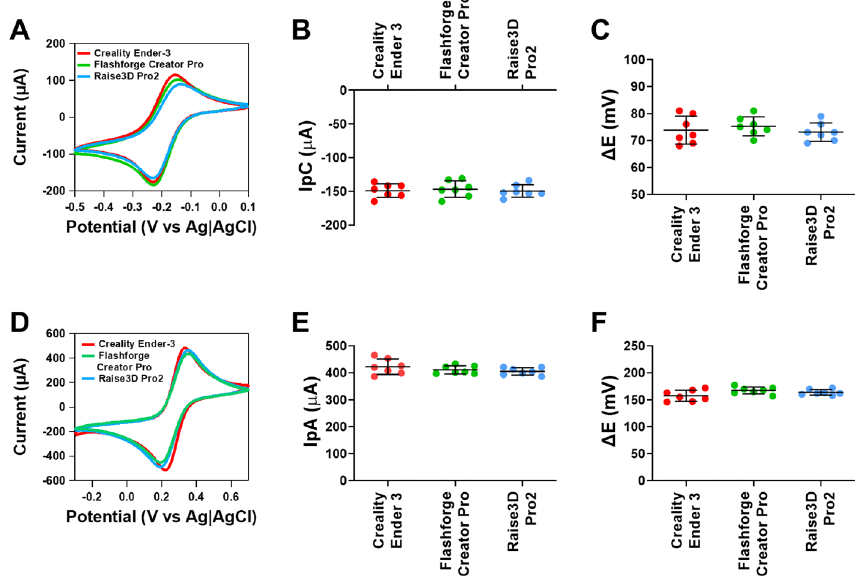
Figure 7. Responses of CB/PLA electrodes made using different 3D printers. ( A ) Representative cyclic voltammograms of 1 mM ruthenium hexaamine in 1 M KCl at 0.05 V s −1 , ( B ) Cathodic peak current, ( C ) ΔE of ruthenium hexaamine ( D ) representative cyclic voltammograms of 5 mM ferricyanide in 1 M KCl at 0.05 V s −1 , ( E ) anodic peak current and ( F ) ΔE of ferricyanide. The extruder temperature was 230 °C, heated bed temperature was 50 °C and the nozzle diameter was 0.6 mm. Data shown as mean ± SD, where n =